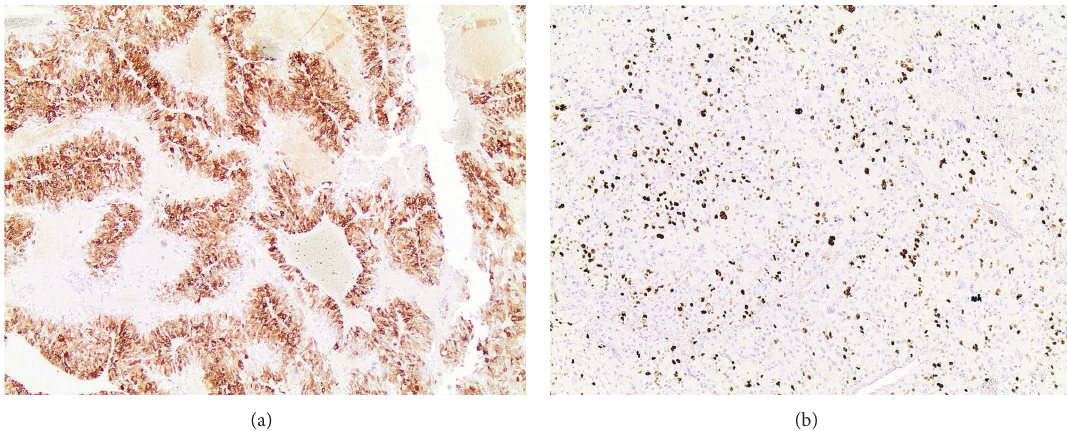
Figure 3: Immunohistochemical staining of adrenal carcinoma. (a) Synaptophysin positivity. (b) Positivity for mitotic index